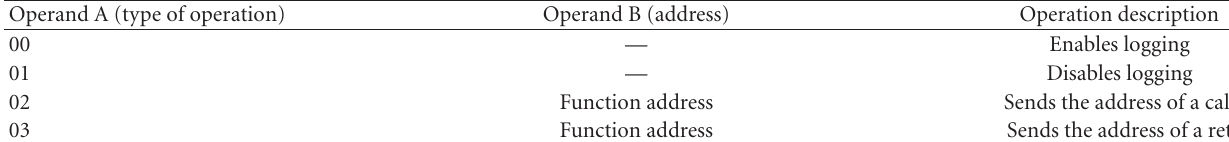
Table 2: Operations implemented by the NIOS custom instruction devoted to tracing.